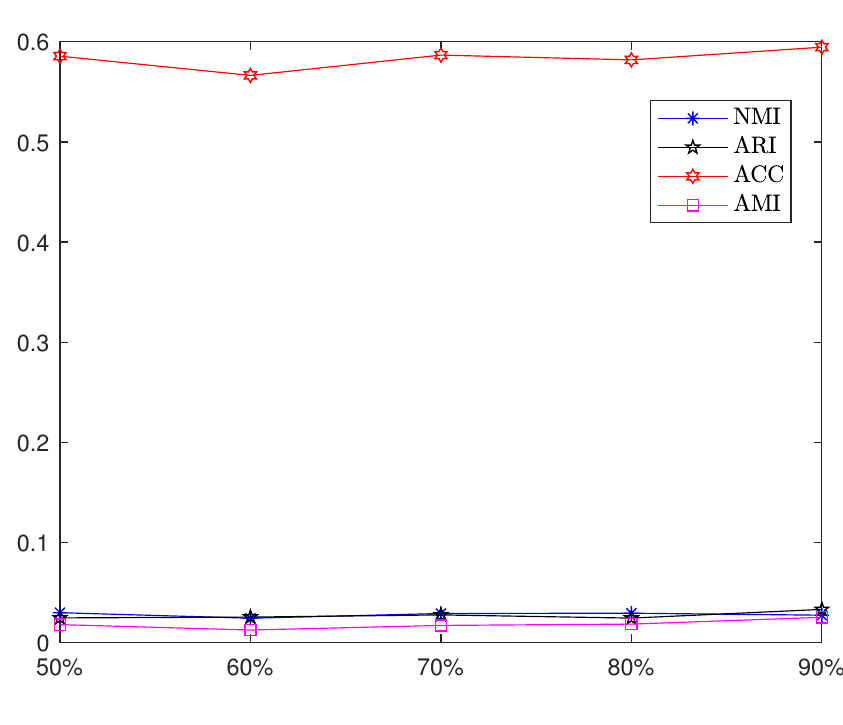
Figure 8. Results of Parkinson by 3WESP.